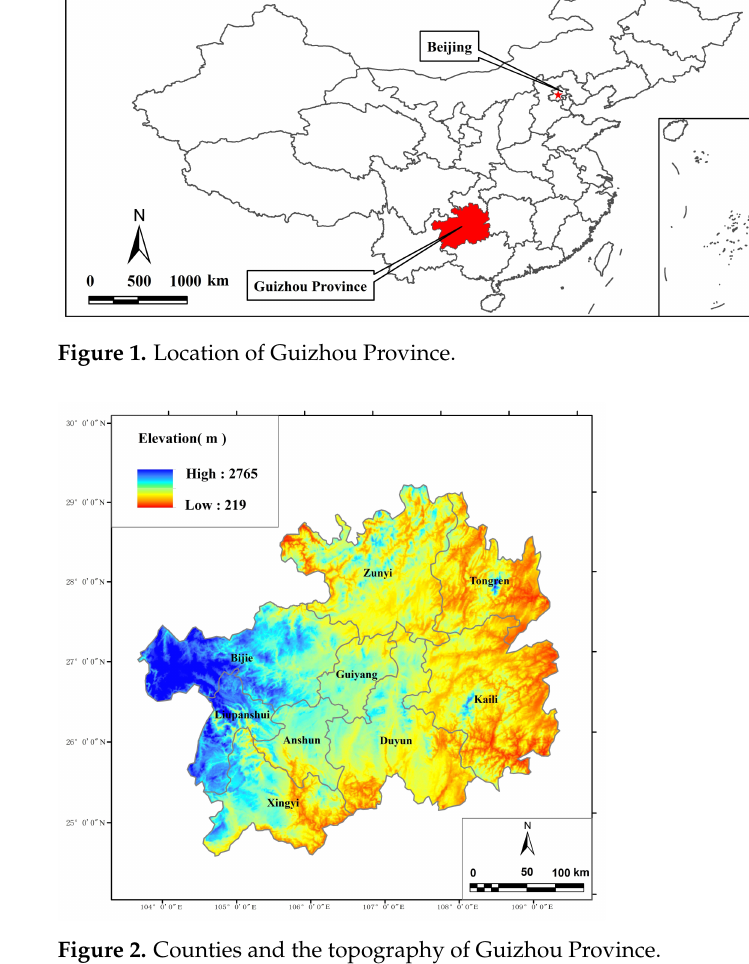
Figure 2. Counties and the topography of Guizhou